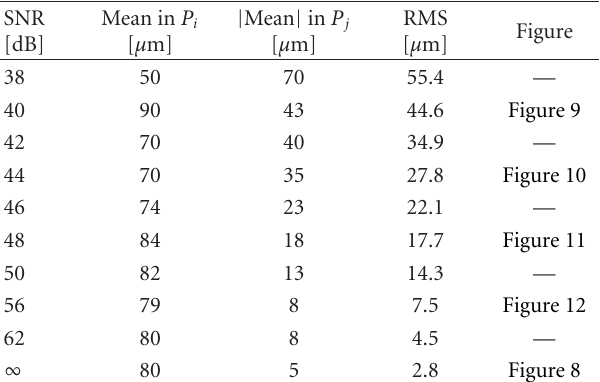
Table 1: Recovered deformations on the reflector surface for varying values of the